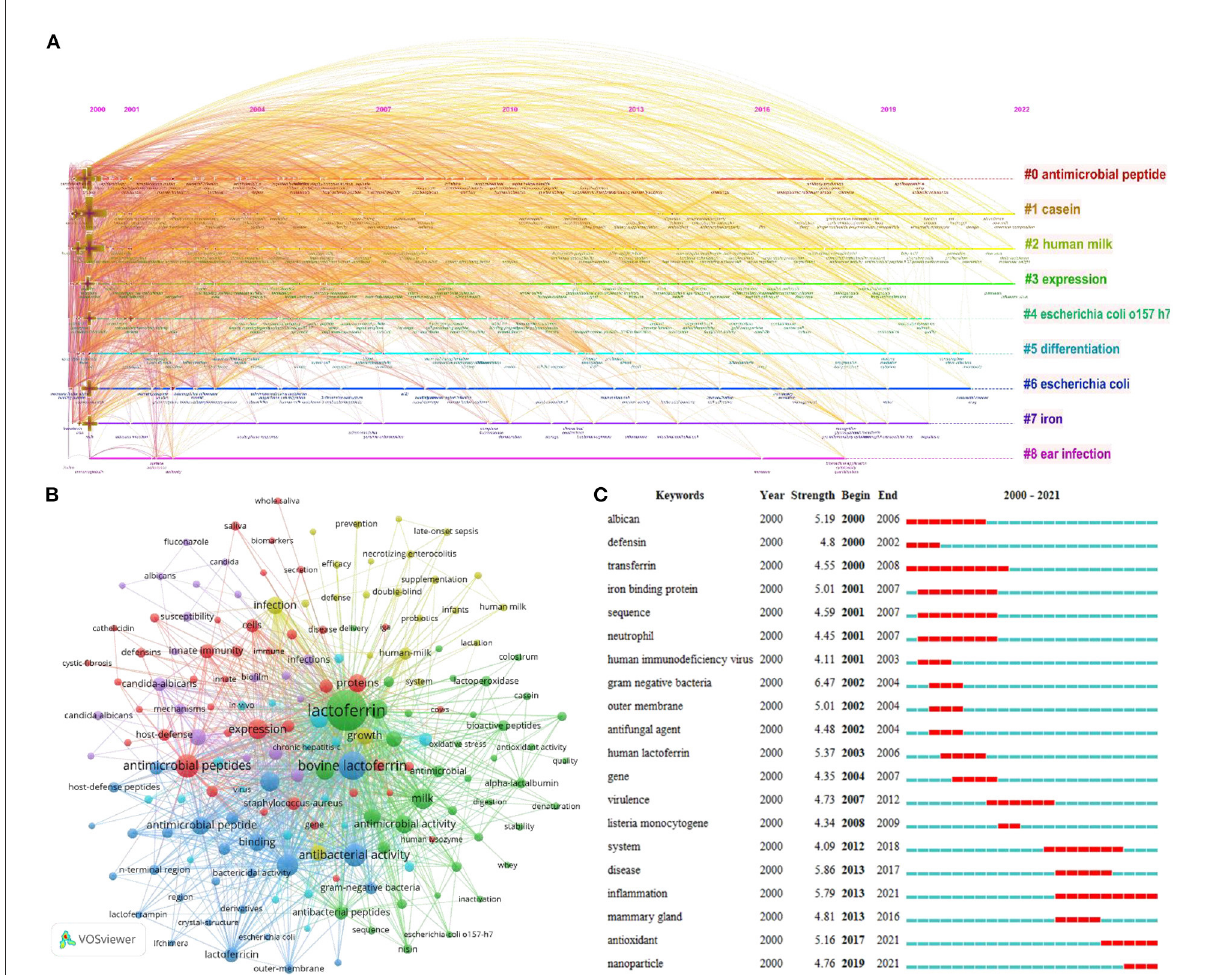
FIGURE8 (A) Timeline view of keywords cluster analysis in LF antibacterial research. (B) Author keyword co-occurrence analysis. (C) Top 20 keywords with strong occurrence burst in LF antibacterial research.